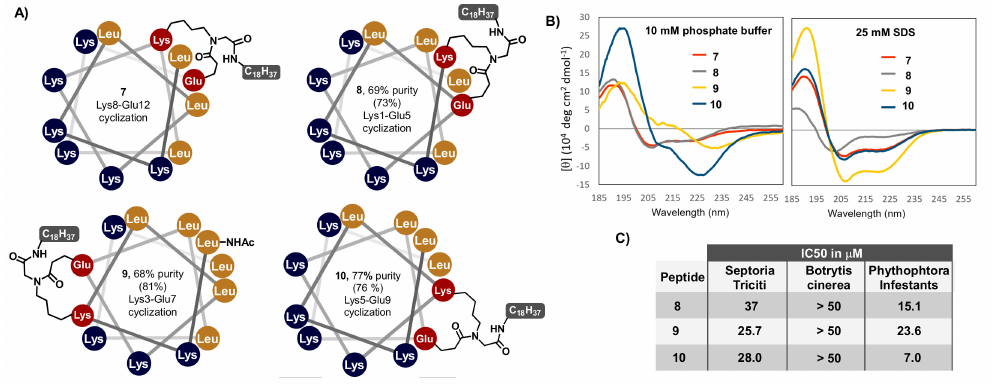
Figure 2. ( A ) Helical wheel representation of the structure of peptides 9-11. In parenthesis the yields of crude products are given; an analytical sample was purified to > 93% purity; ( B ) CD spectra for the peptides in 10 mM phosphate bu ff er and 25 mM SDS aqueous solutions, including the spectrum of 8 for comparison purposes;( C ) Bioactivity of the compounds against model